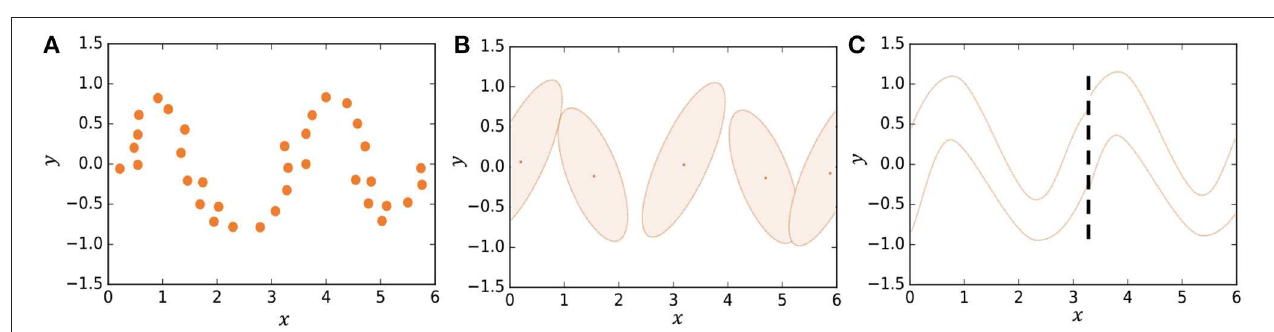
FIGURE 2 | Representing a trajectory: (A) Observed data points, (B) representation by HMM, and (C) representation by